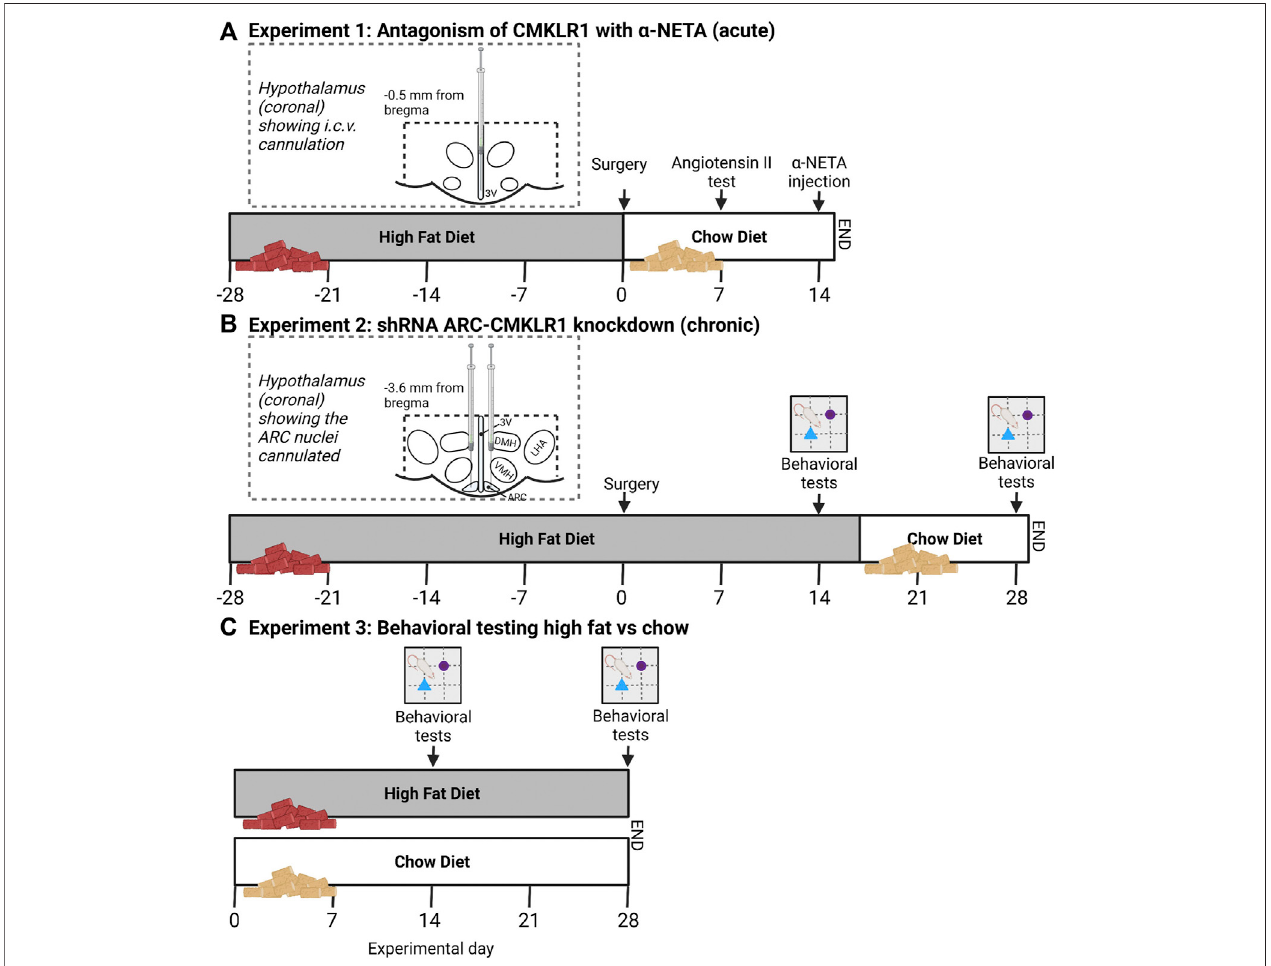
FIGURE 1 | Schematic study design and timeline. (A) In experiment 1, Sprague Dawley rats received a high-fat diet for 28 days before i.c.v. cannulation. After surgery, rats were put on a chow diet. 7 days after surgery correct cannula placement was con fi rmed via Angiotensin II injections. 14 days after surgery, rats received a bolus injection of α -NETA, a selective CMKLR1 antagonist and body weight and food intake was measured 24 h after injection. (B) In experiment 2, lentivirus vectors expressingshRNAtargetedagainstCMKLR1(ARC-CMKLR1-KD)orscrambledviruswasbilaterallyinjectedintothearcuatenucleus(ARC)ofSpragueDawleyrats on high-fat diet for 28 days. Diet was switched to chow diet after 17 days following surgery. Body weight was measured daily. Behavioral testing was carried out at experimental days 14 and 28. The inserts show the diagrammatic representation of the hypothalamus (coronal sections) showing the cannulated coordinates. The dottedlinesborderingthehypothalamusindicatethehypothalamicareathatwasdissectedforgeneanalysis. (C) InExperiment3,SpragueDawleyratsweredividedinto two groups, one group was provided ad libitum with high-fat diet and the other group received nutrient matched chow diet. Rats were tested in the Novel object recognition (NOR) after 14 and 28 days of intervention to provide baseline behavioral data (created with